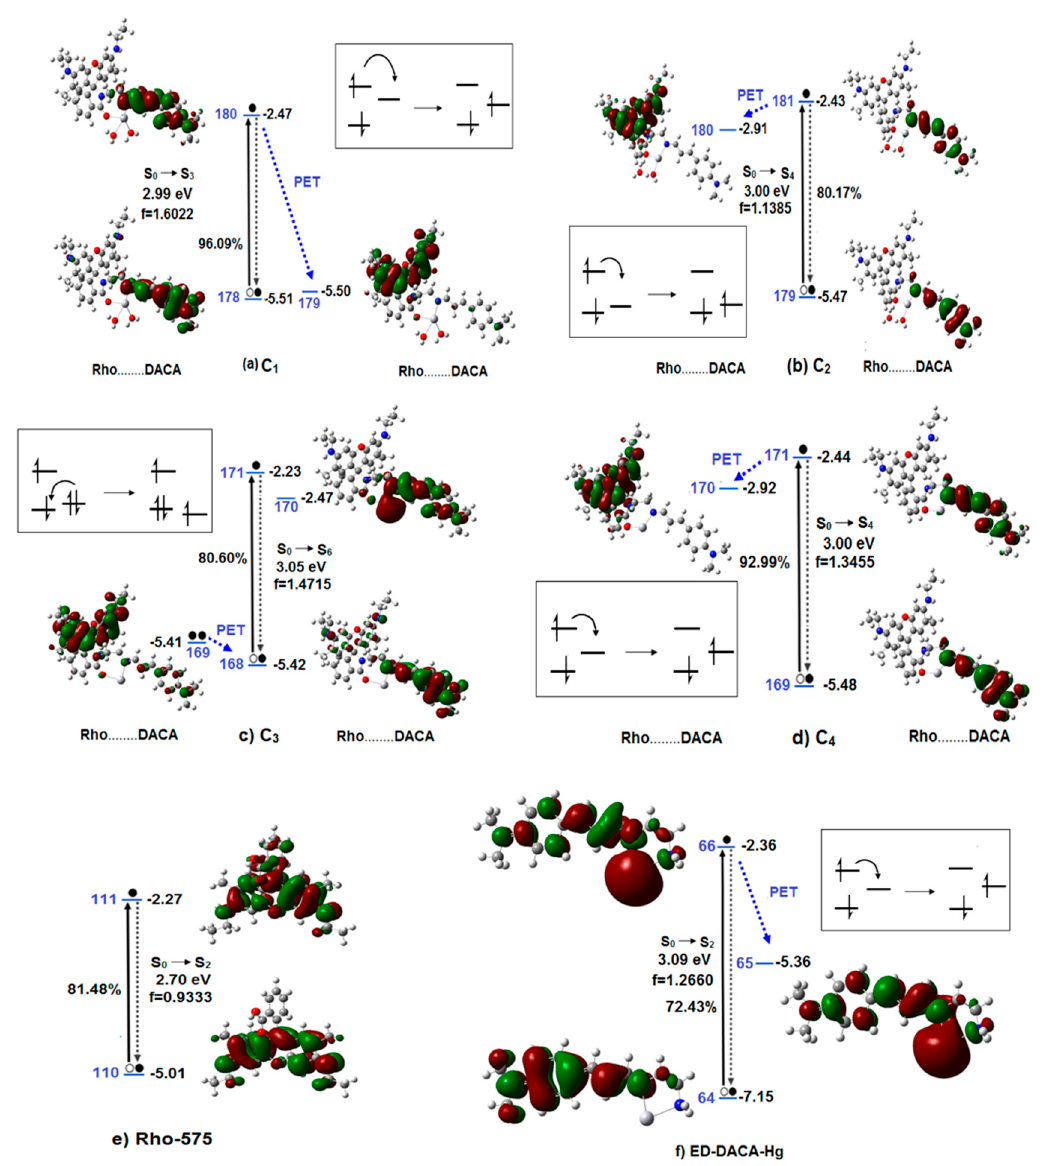
Figure 5. The frontier orbital energy diagram of ( a ) C 1 , ( b ) C 2 , ( c ) C 3 , ( d ) C 4 , ( e ) Rho-575, and ( f ) ED-4-dimethylamino-cinnamaldehyde (DACA)-Hg (the energy levels are relative, not in proportion; summary of the main state transitions with the strongest oscillator strength, and the main orbital transitions with the largest percentage of contribution.